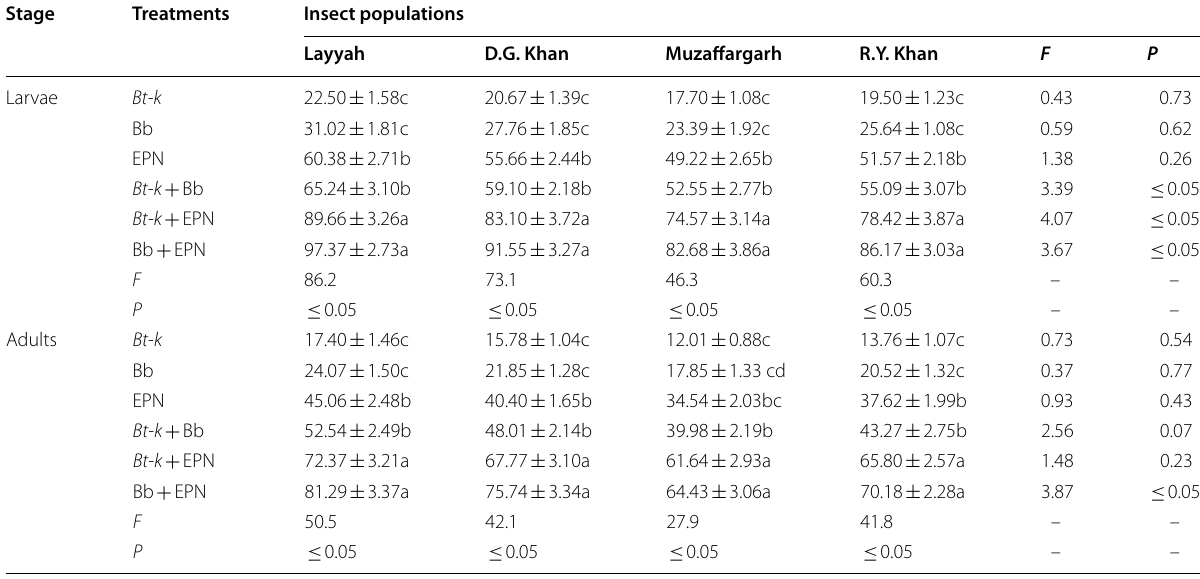
Mortality% followed by the same letter within each treatment and insect populations are not significantly different; HSD test P kurstaki , Bb: Beauveria bassiana , EPN: Heterorhabditis bacteriophora )